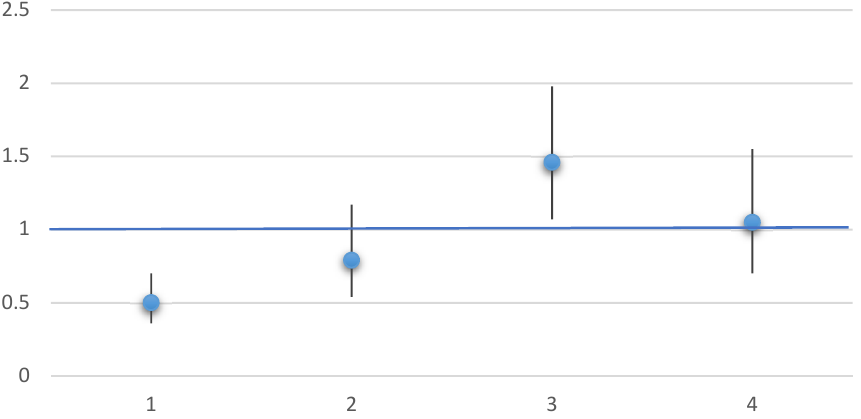
Figure 1. Odds ratio of high self-perceived fitness and overweight in MCS All or MCS with no comorbid FSD. 1: OR (95%CI) of high self-perceived fitness in MCS All adjusted for sex and age. 2: OR (95%CI) of high self-perceived fitness MCS with no comorbid FSD adjusted for sex and age. 3: OR (95%CI) of BMI > 25 kg/m 2 in MCS All Adjusted for sex, age, and ageˆ2. 4: OR (95%CI) of BMI > 25 kg/m 2 in MCS with no comorbid FSD Adjusted for sex, age, and ageˆ2. FSD Functional Somatic Disorder. High self-perceived fitness: participants who answered “good” or “very good” on a 5-point scale for self-perceived